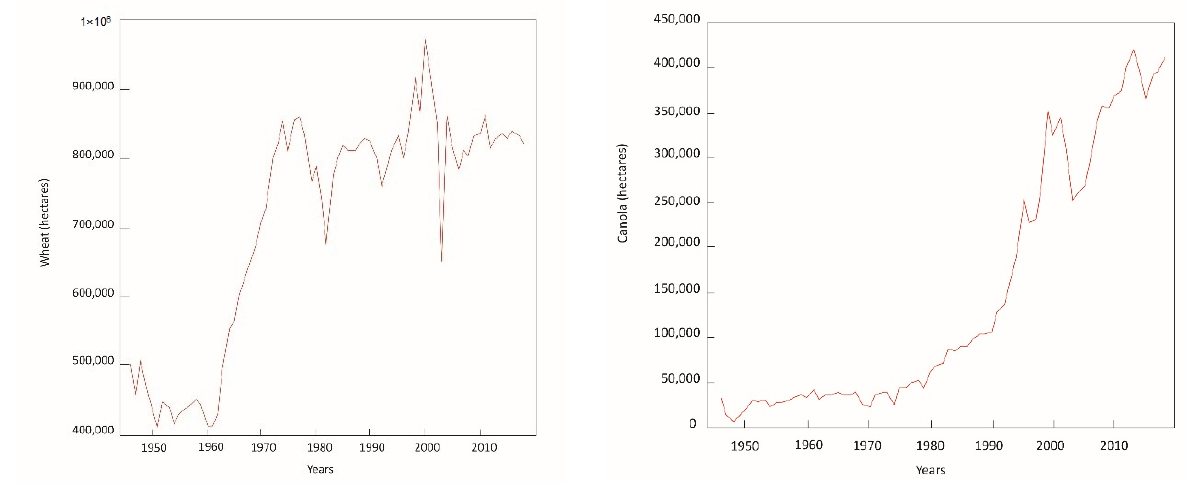
Figure 1. Development of wheat and canola sowing areas in the Czech Republic.